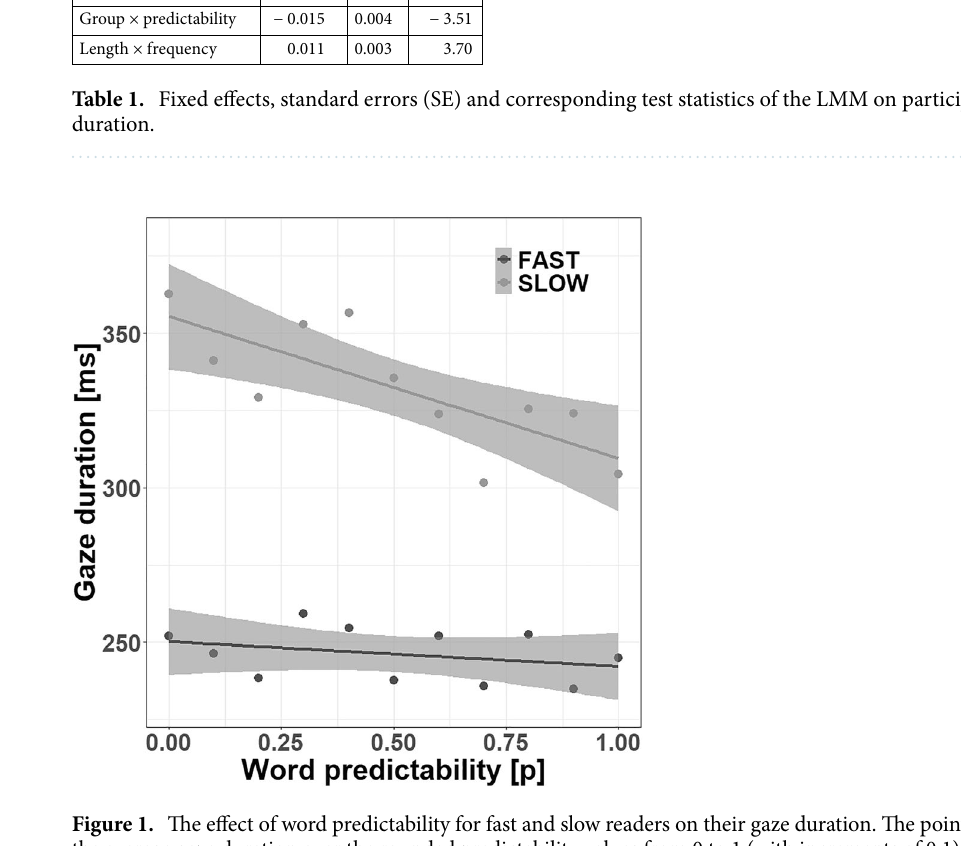
Figure 1. The effect of word predictability for fast and slow readers on their gaze duration. The points represent the average gaze duration over the rounded predictability values from 0 to 1 (with increments of 0.1). The shaded areas denote 95% pointwise confidence